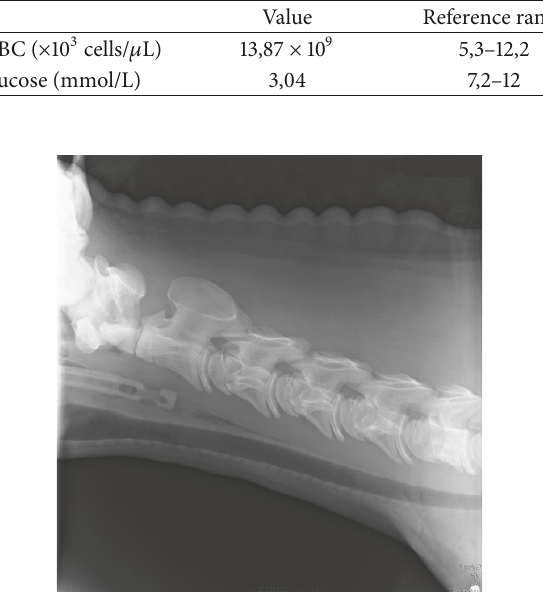
Figure 1: Lateral radiographic view of the cervical area. The nasogastric tube can be seen advanced up to the stricture site at approximately the second cervical vertebra.